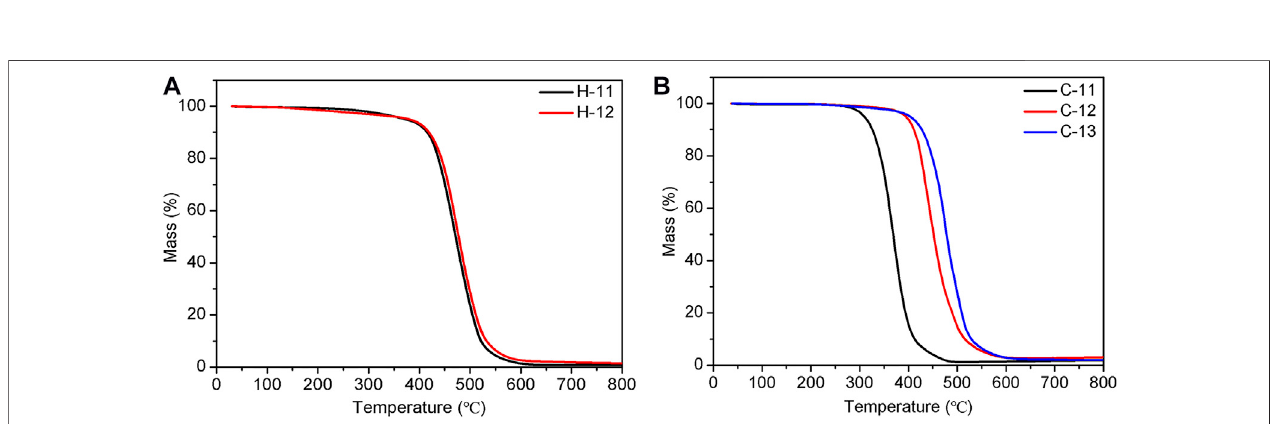
FIGURE 11 | TGA curves of hydrogen bond crosslinked SEs, H-11 and H-12 (A) , and covalent bond crosslinked SEs, C-11 to C-13 (B) .